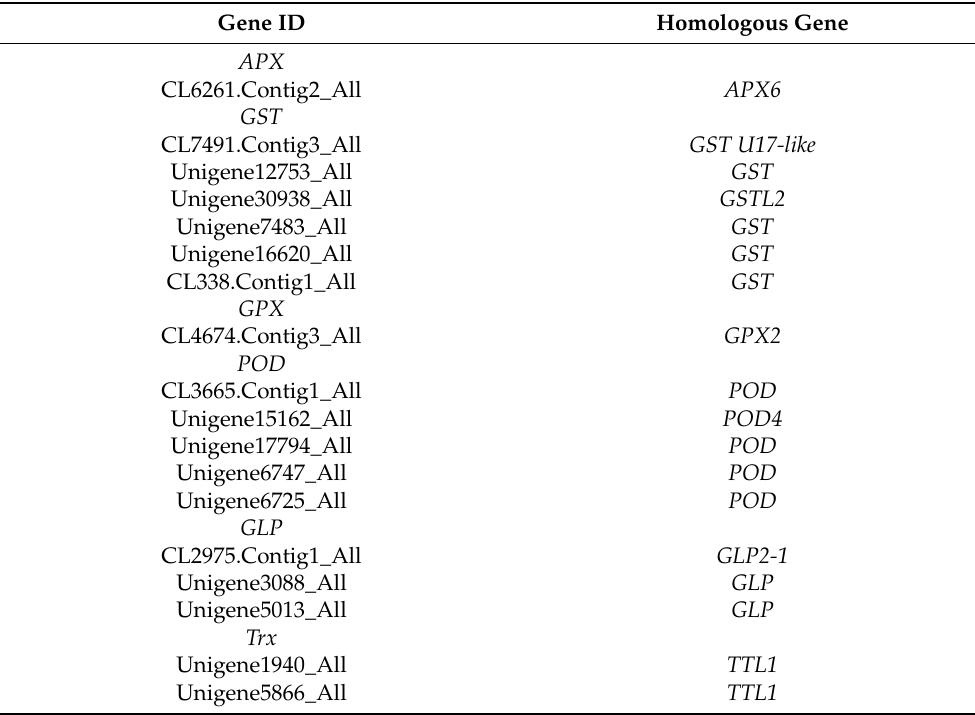
Table 3. The upregulated DEGs related to the ROS scavenging system in the leaves of A. canescens under 100 mM NaCl for both 6 and 24 h.